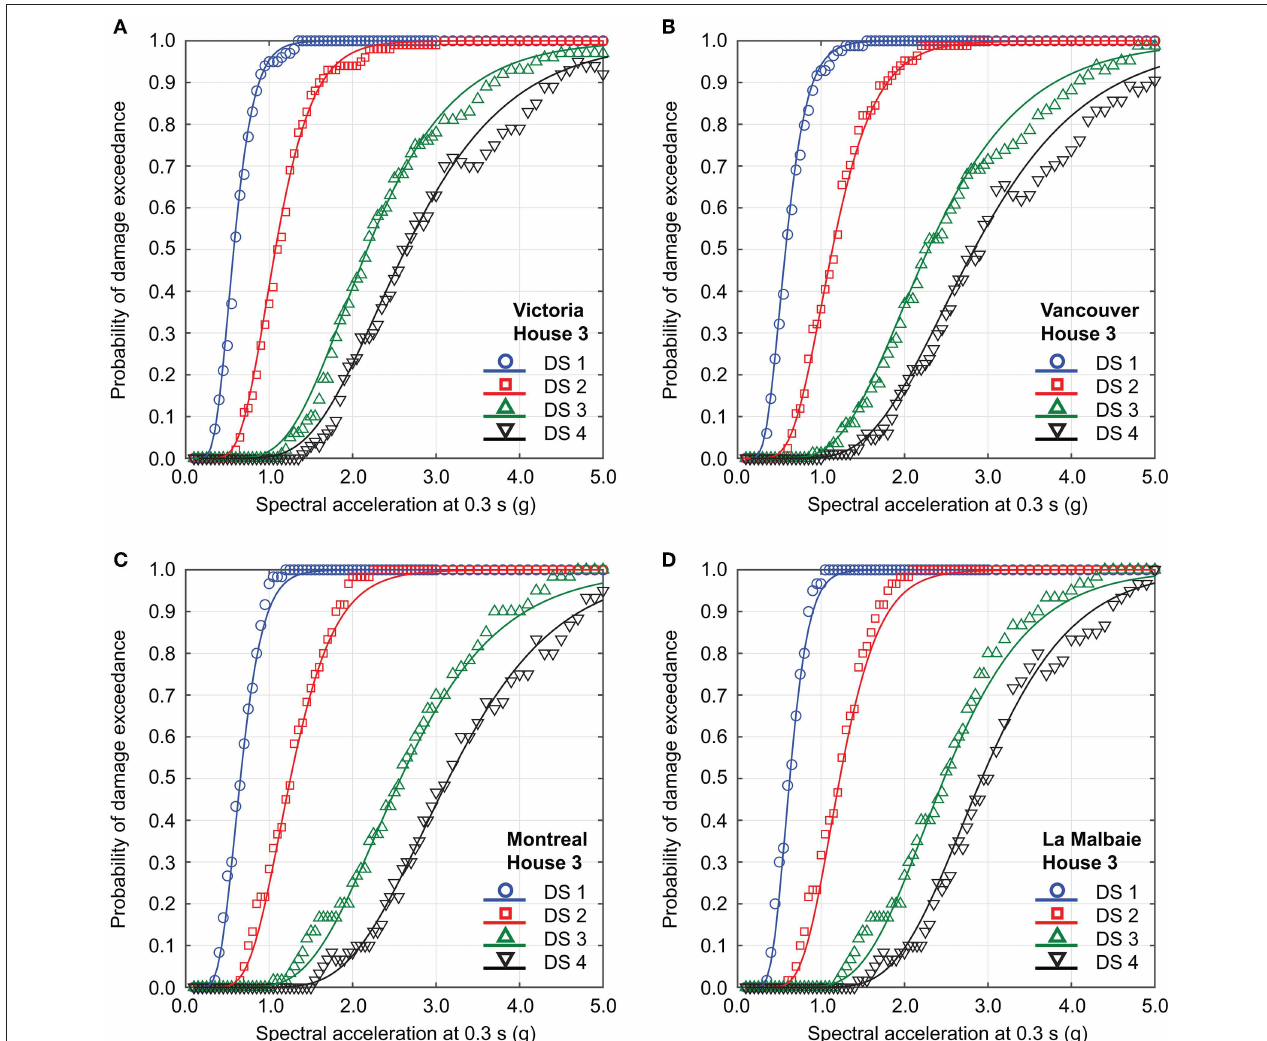
FIGURE 9 | Seismic fragility functions for House 3: (A) Victoria, (B) Vancouver, (C) Montreal, and (D) La Malbaie.